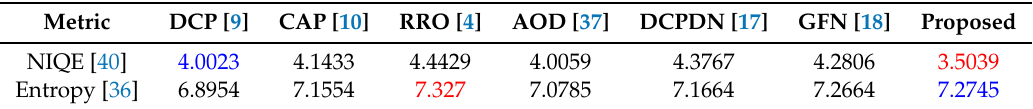
Table 9. Comparative results of dehazing methods on FADE [36]. Best score is marked in red, and the second best score is marked in blue.